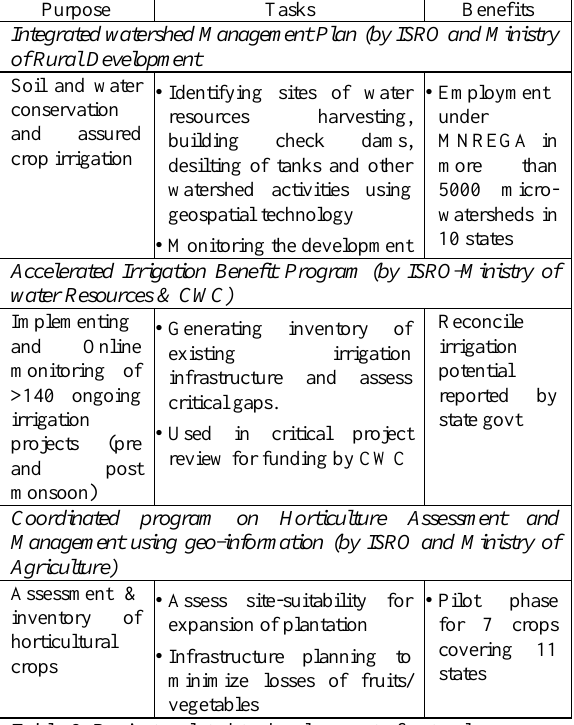
Table-3. Projects related to development of natural resources Projects related to natural/ cultural resource conservation will help in restoration / conservation and management of national resources in a better way (Table-4).